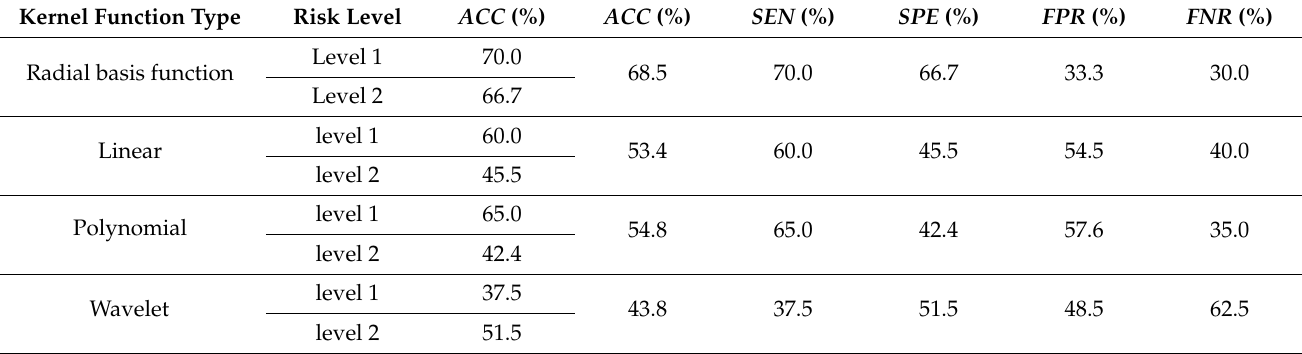
Table 3. Prediction result of different kernel functions. SEN: Number of correct and positive validation predictions, as a percentage of positive numbers. SPE: The number of predictions that are